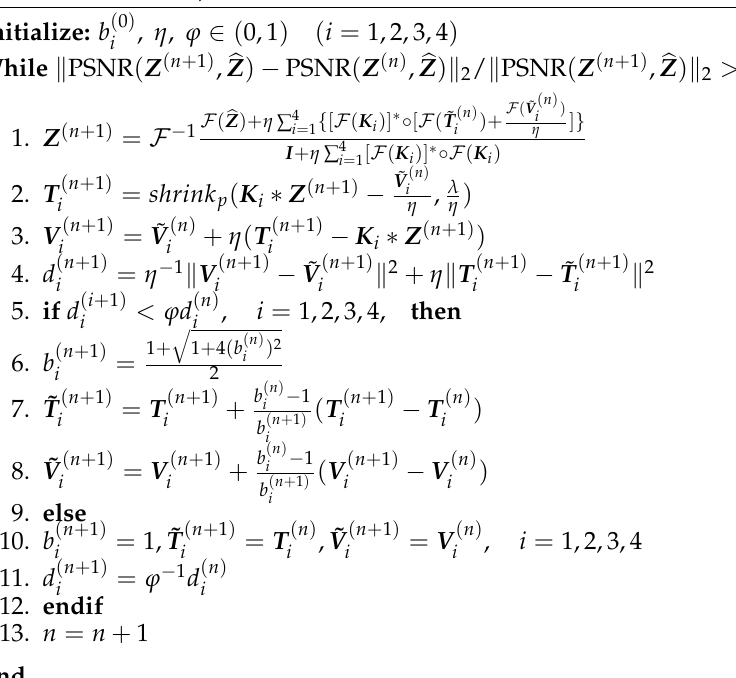
Algorithm 3 FTV4L p denoising using the fast